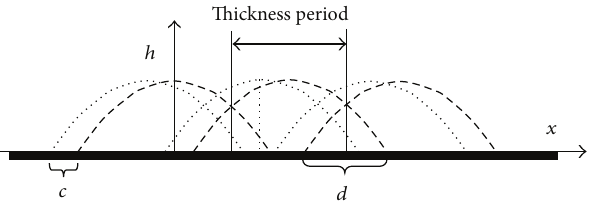
Figure 6: Coating thickness distribution when 𝑐 ≤ 0.5𝑑 , 𝑐 + 𝑑 > 0.5 and 𝑐 + 2𝑑 ≤ 1 .